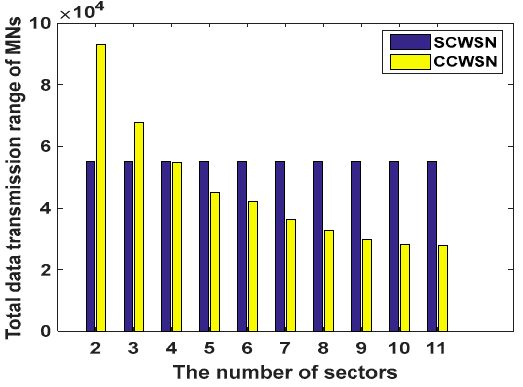
Figure 4. The influence of the angle of sectors on.